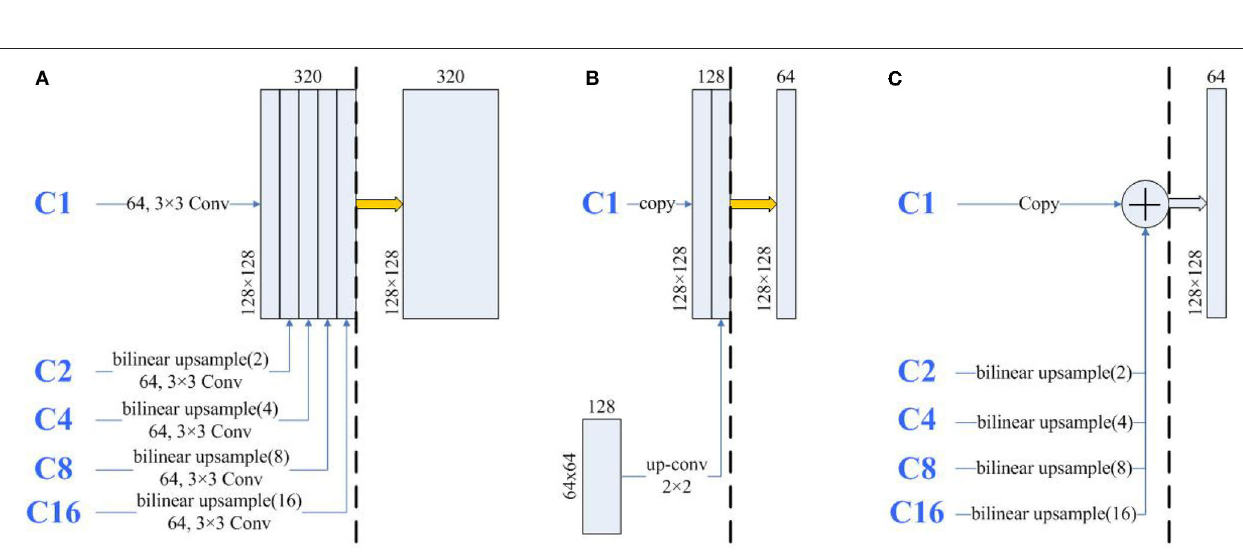
Frontiers in Neuroinformatics |